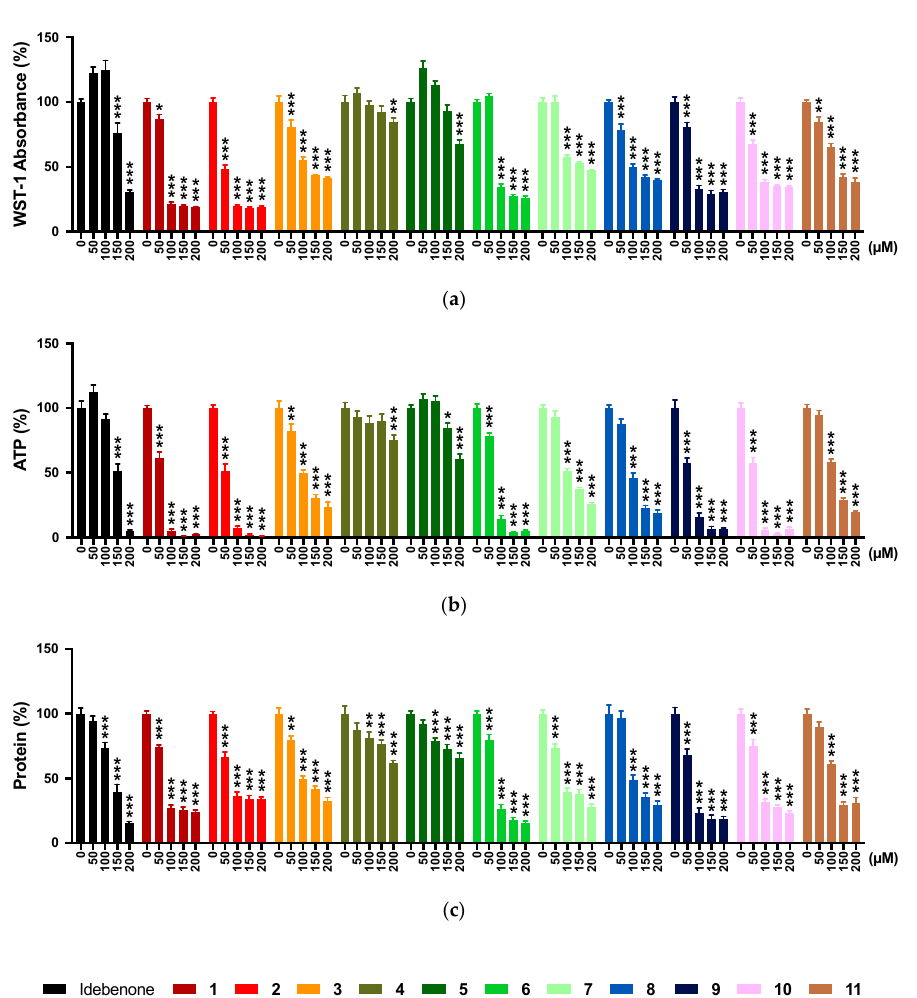
Figure 1. Effect of test compounds on metabolic toxicity. Cells were exposed to reference and test compounds (0–200 μ M) for 24 h before ( a ) WST-1 absorption; ( b ) ATP levels; ( c ) protein contents were quantified. Data represents mean ± SEM of 3 independent experiments with 6 parallel wells per experiment. Two-way ANOVA was performed to compare test concentrations against the non-treated control: *** p < 0.001, ** p < 0.002, * p < 0.033. Full datasets shown in Tables S1–S3.